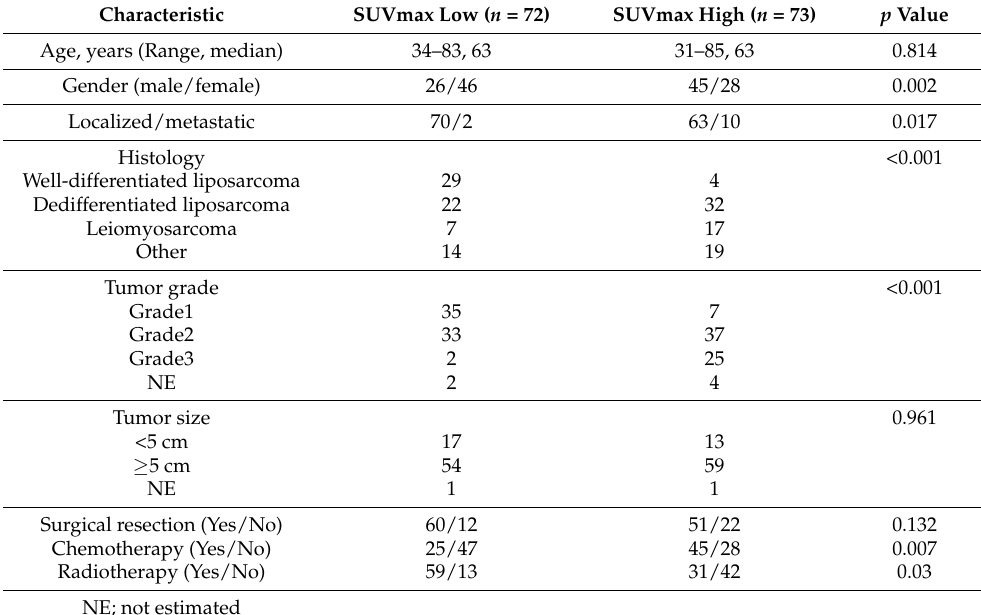
Table 2. Clinicopathologic and treatment characteristics between SUVmax low and SUVmax high.